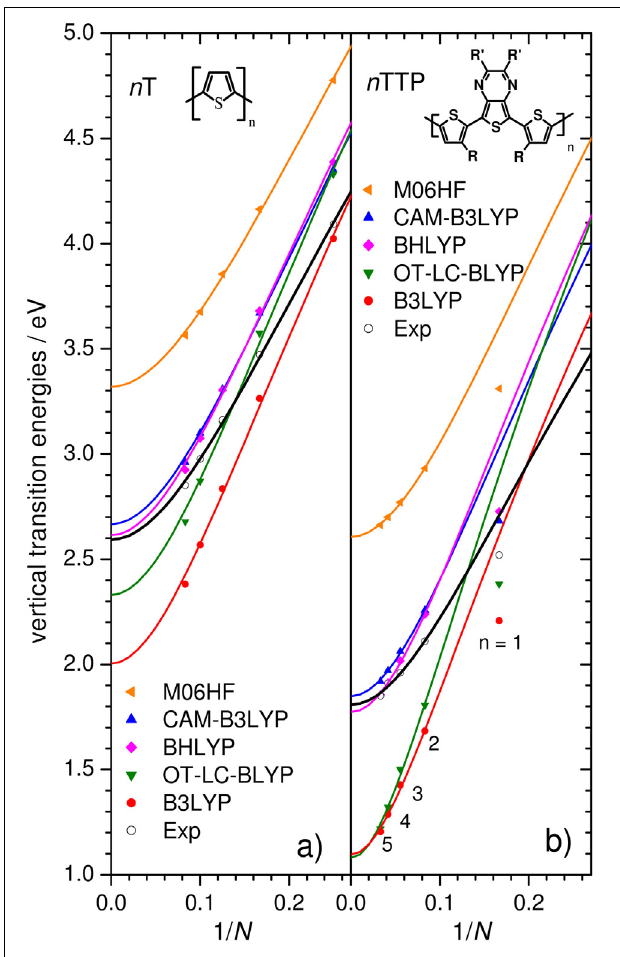
FIGURE 6 | E vert of n Ts (A) and n TTPs (B) computed using a range of DFT functionals for both geometry optimization (planar C 2v /C 2h ) and transition energies (solid symbols) and Kuhn fits (lines). Experimental results (open symbols; n Ts: in DCM, n TTP: in toluene) are shown for